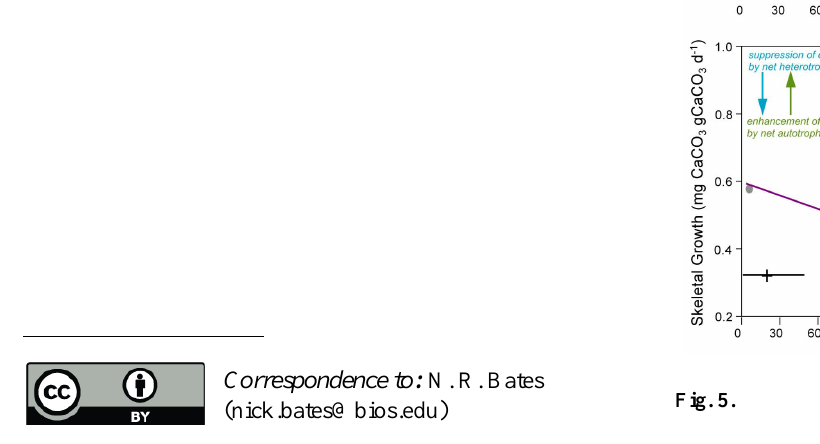
Fig. 5. Note: The Fig. 5 caption incorrectly referred to a panel (d). The caption should read as follows. (a) Annual composite of rates of NEC reef (g CaCO 3 m − 2 d − 1 ; green line) and NEP reef (gCm − 2 d − 1 ; blue line) for the Bermuda reef using seawater TA and DIC data from Hog Reef and BATS, and the alkalinity anomaly-water mass residence technique. Posi- tive NEC reef values represent net calcification, and negative values represent net dissolution, with the zero line denote by grey dashed line. Positive NEP reef values represent net heterotrophy, and neg- ative values represent net autotrophy, with the zero line denote by grey dashed line. (b) Annual composite and comparison of sur- face seawater [CO 2 − ] data (µmoleskg − 1 ; gray circles) and skele- 3 tal growth rates (i.e., G diploria ; mg CaCO 3 g − 1 d − 1 ) for Hog Reef and Twin Breakers (Table 2). (c) Repeat of (b) showing the CREF hypothesis superimposed on Hog Reef data. In early summer, en- hancement of [CO 2 − ] and calcification during June and July [green 3 arrow] occurs due to positive NEP. In late summer, suppression during September and October on the Bermuda reef due to nega- tive NEP (blue arrow). The dashed line illustrates the hypothesized [CO 2 − ] in absence of the feedback on carbonate chemistry due to 3 seasonal changes in